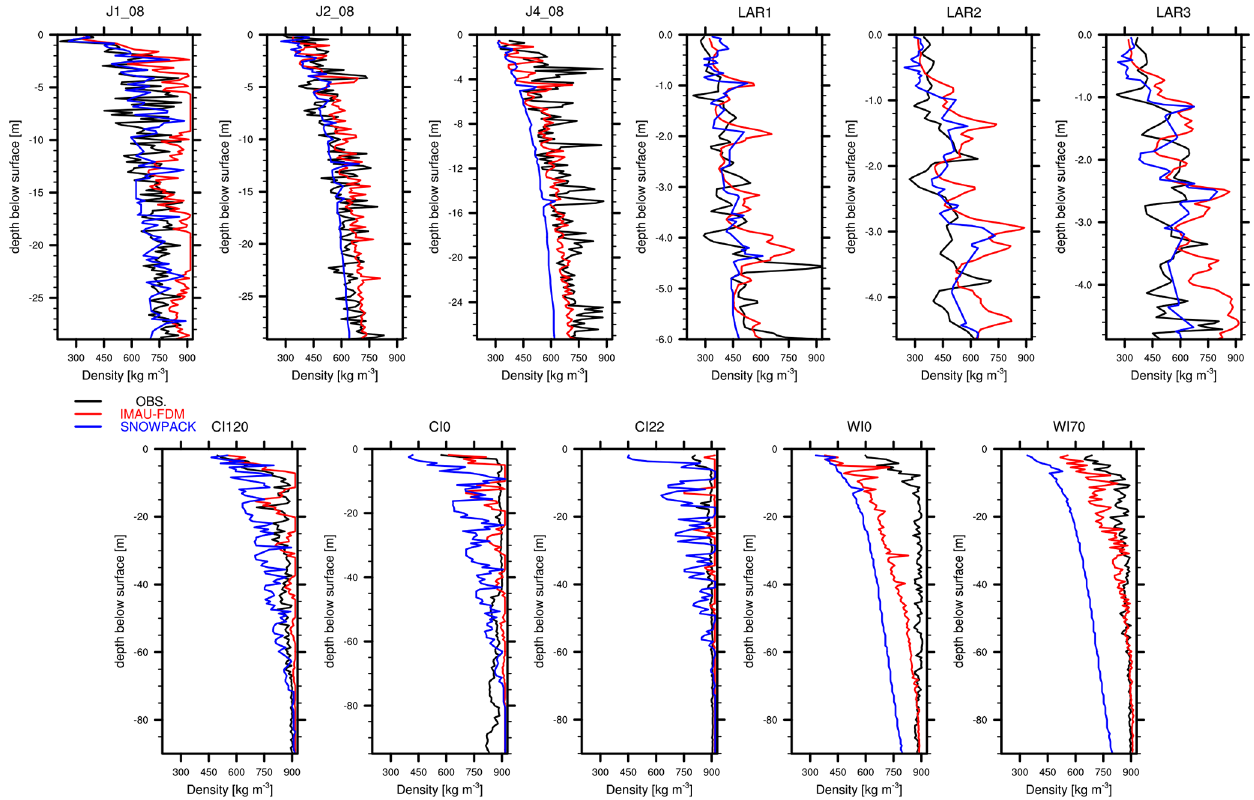
Figure 3. Modelled IMAU-FDM (red), SNOWPACK (blue), and observed (black) density profiles for 11 locations on the Larsen C Ice Shelf (Sect. 2.4.2).